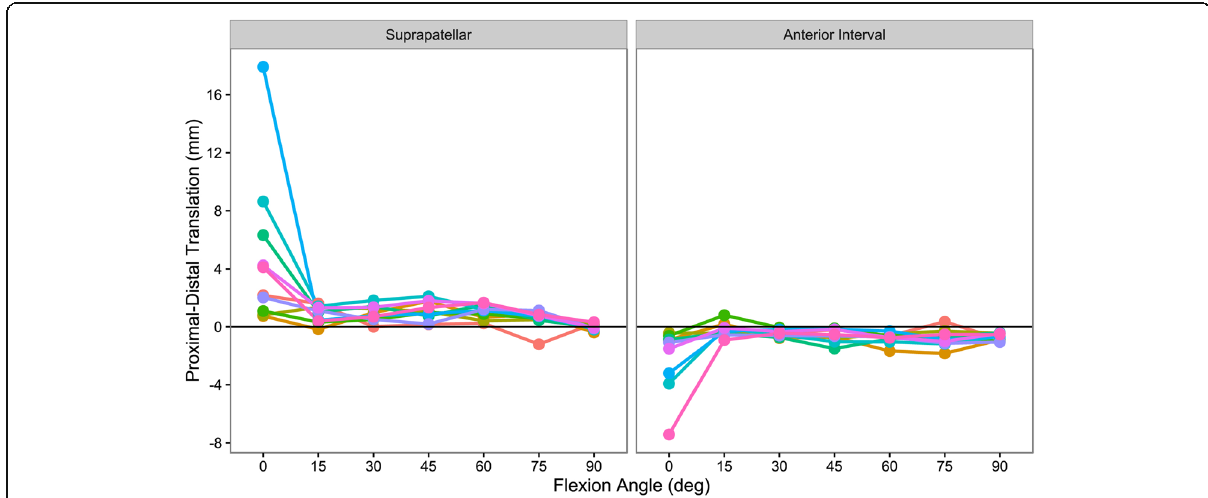
Fig. 4 Proximal (+) and distal ( − ) translation of the patella with simulated adhesions. Suprapatellar adhesions tended to result in proximal patellar translation and anterior interval adhesions tended to result in distal translation, and these effects were most pronounced at 0° of knee flexion. Colored lines connect measurements made on the same